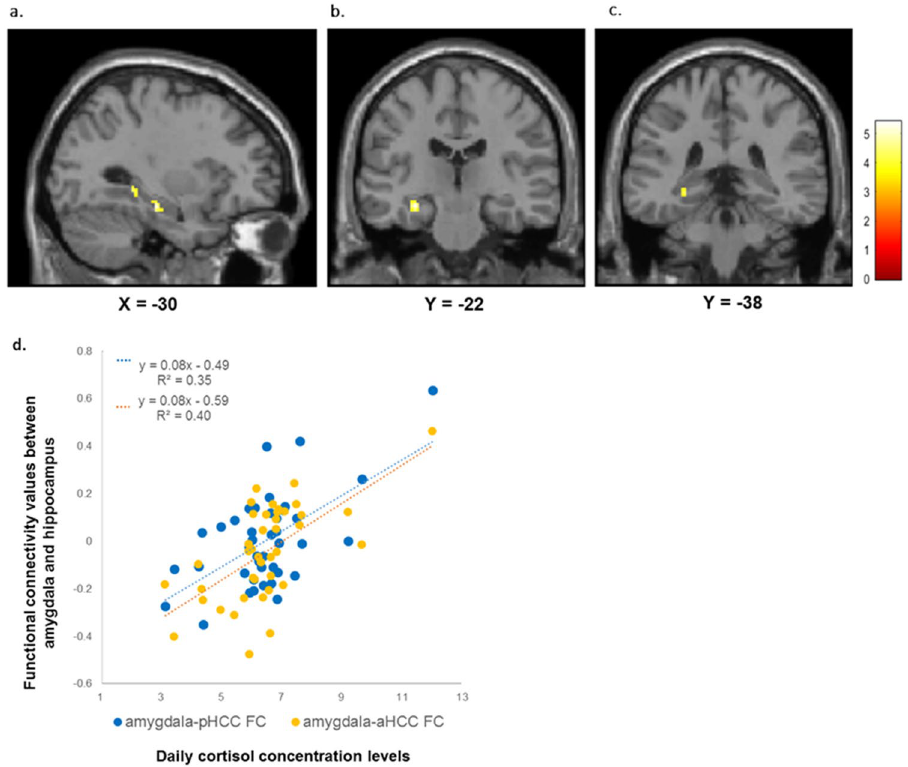
Figure 2. The HC displays greater FC with the amygdala during the perception of fearful faces (vs. neutral faces). ( a ) Significantly heightened FC between the amygdala and 2 different clusters within the HC (its strength parallels dCOR levels); ( b ) Anterior part of the HC (MNI − 30 − 22 − 16, 280 mm 3 , T = 5.41, p < 0.001); ( c ) Posterior part of the HC (MNI − 30 − 38 − 4, 144 mm 3 , T = 4.30, p < 0.001). These clusters were also significant at FWE-corrected p < 0.05 with SVC. Colour bar indicates T-value. ( d ) Scatter plot of the relationship between dCOR and amygdala-HC FC values in fearful faces processing (vs. neutral faces). Amygdala-pHCC FC values (blue circle). Amygdala-aHCC FC values (orange circle). Regression line of amygdala-pHCC FC (blue dotted line). Regression line of amygdala-aHCC FC (orange dotted line). Abbreviations: HC, hippocampus; FC, functional connectivity; dCOR, daily cortisol concentrations; MNI, Montreal Neurological Institute space; SVC, small volume correction; pHCC, a posterior part of the HC; aHCC, an anterior part of the